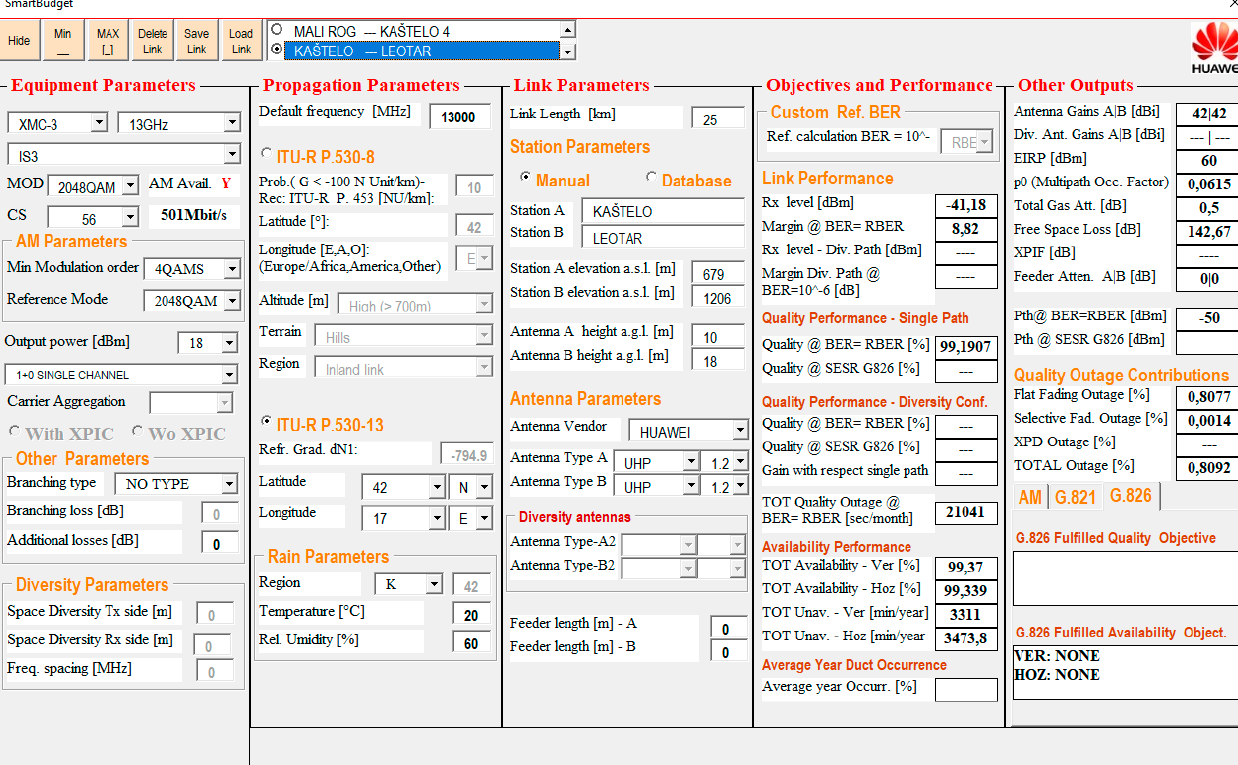
Figure 10. Prediction for the fifth RR section; 2048 QAM, 500 Mb/s.